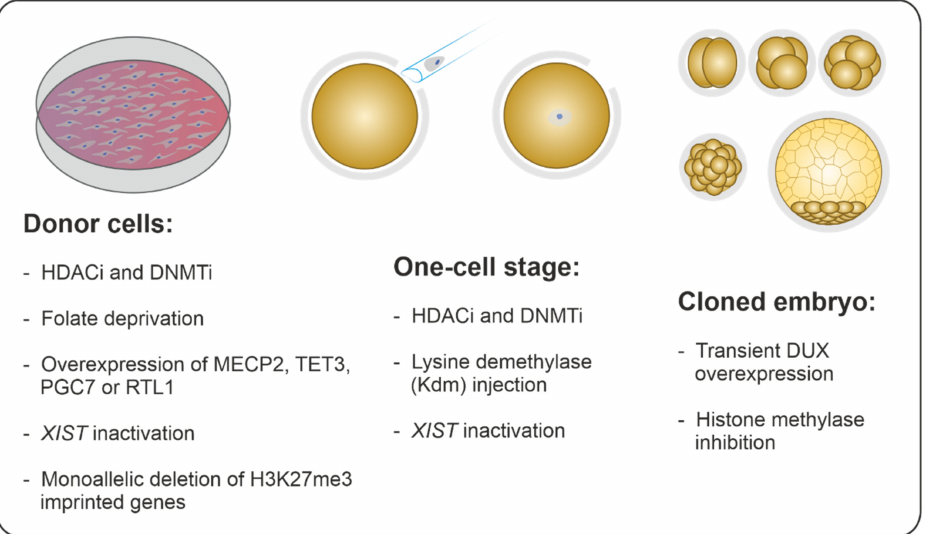
Figure 1. Epigenome Manipulation in Somatic Cell Nuclear Transfer (SCNT): possibilities to improve the outcome of SCNT experiments in the different steps of the procedure. HDACi: histone deacetylase inhibitors; DNMTi: DNA methyl-transferase inhibitors; MECP2: methyl-CpG–binding protein 2; TET3: tet methylcytosine dioxygenase 3; PGC7: primordial germ cell 7; RTL1: retrotransposon Gag like 1; XIST: X inactive specific transcript; H3K27me3: tri-methylation of histone-H3 lysine 27; DUX: double